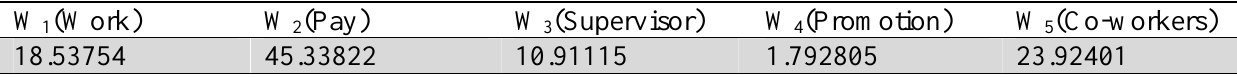
The summary of weights